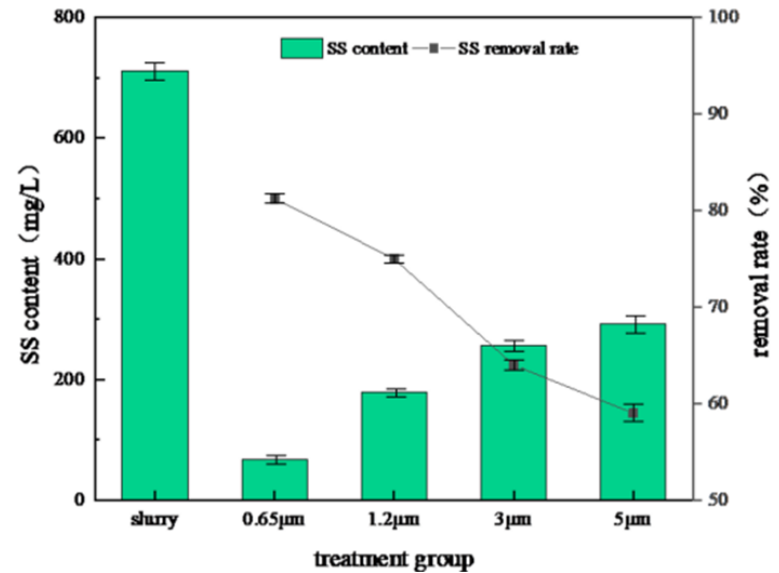
Figure 1. Effects of the microfilter membrane system on SS.